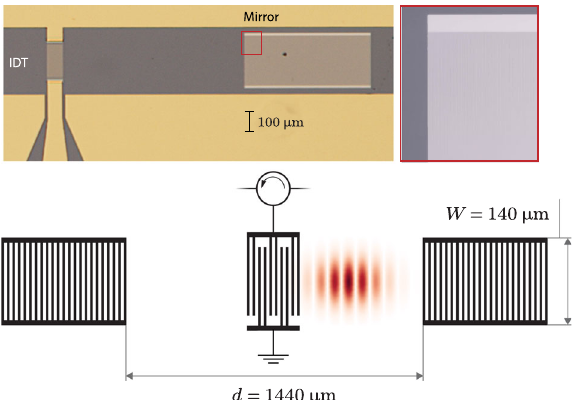
Fig. 4 Device layout. Microscope image showing the IDT and right hand Bragg mirror and schematic illustration of the SAW resonator. The IDT and mirrors are fabricated in aluminium on a GaAs substrate with gold ground planes. Inset shows part of the Bragg mirror. The IDT with 50 periods provides a coupling port and is centered with respect to the Bragg mirrors. The mirrors have N = 800 fi ngers each that are shorted together. As the length of the resonator is more than 1000 wavelengths, the spatial distributions of the different modes are nearly identical. The resonator is measured in re fl ection using a microwave